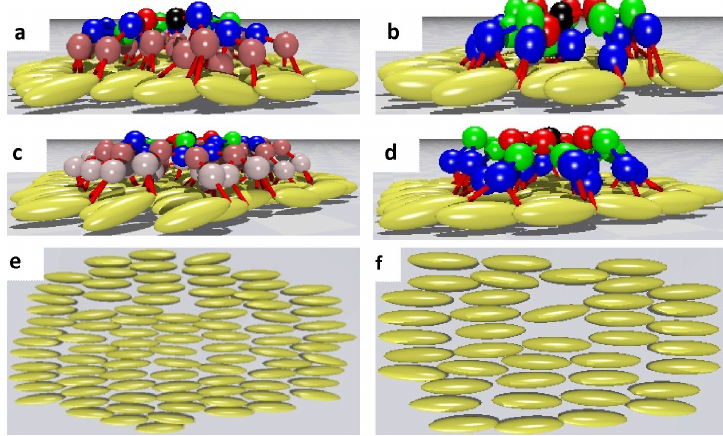
Figure 9. Snapshots of LCDrs under uniform planar anchoring conditions at T ∗ = 0 . 6 . D D D ( a ) G ; ( b ) G ; ( c ) G and ( d ) G 4 3 3 4 5 3 D and G LCDrs without the junction 3 5